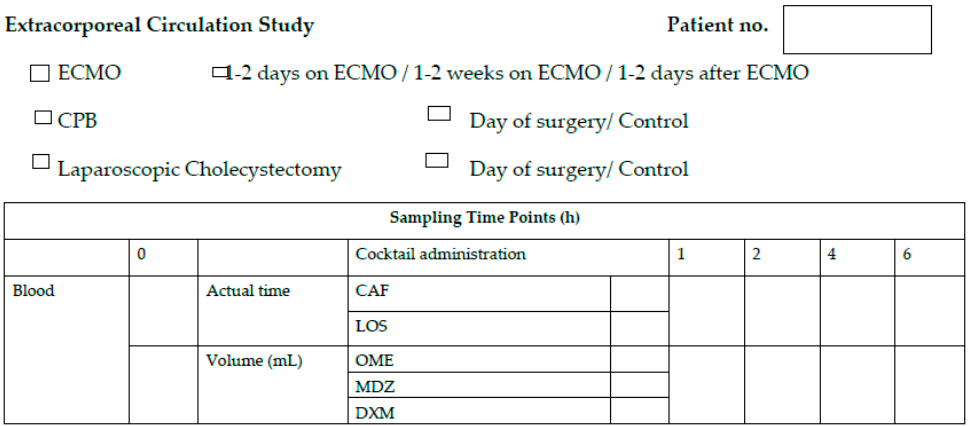
Figure 1. Blood Sampling Schedule.